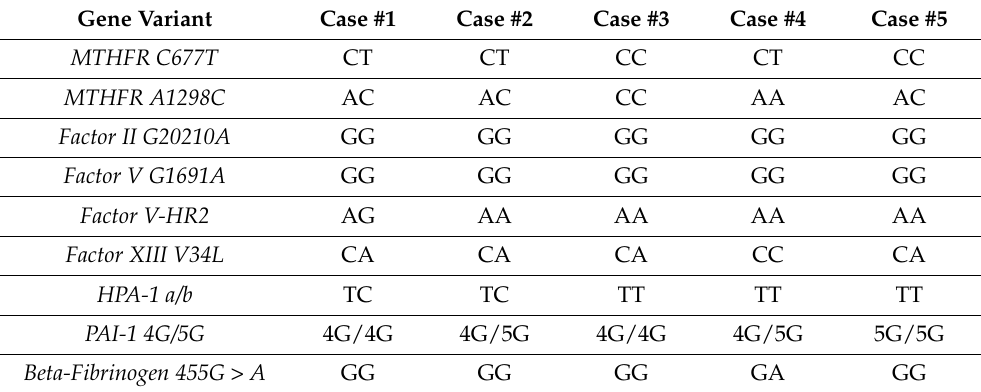
Table 3. Results of the genetic analysis performed on whole blood